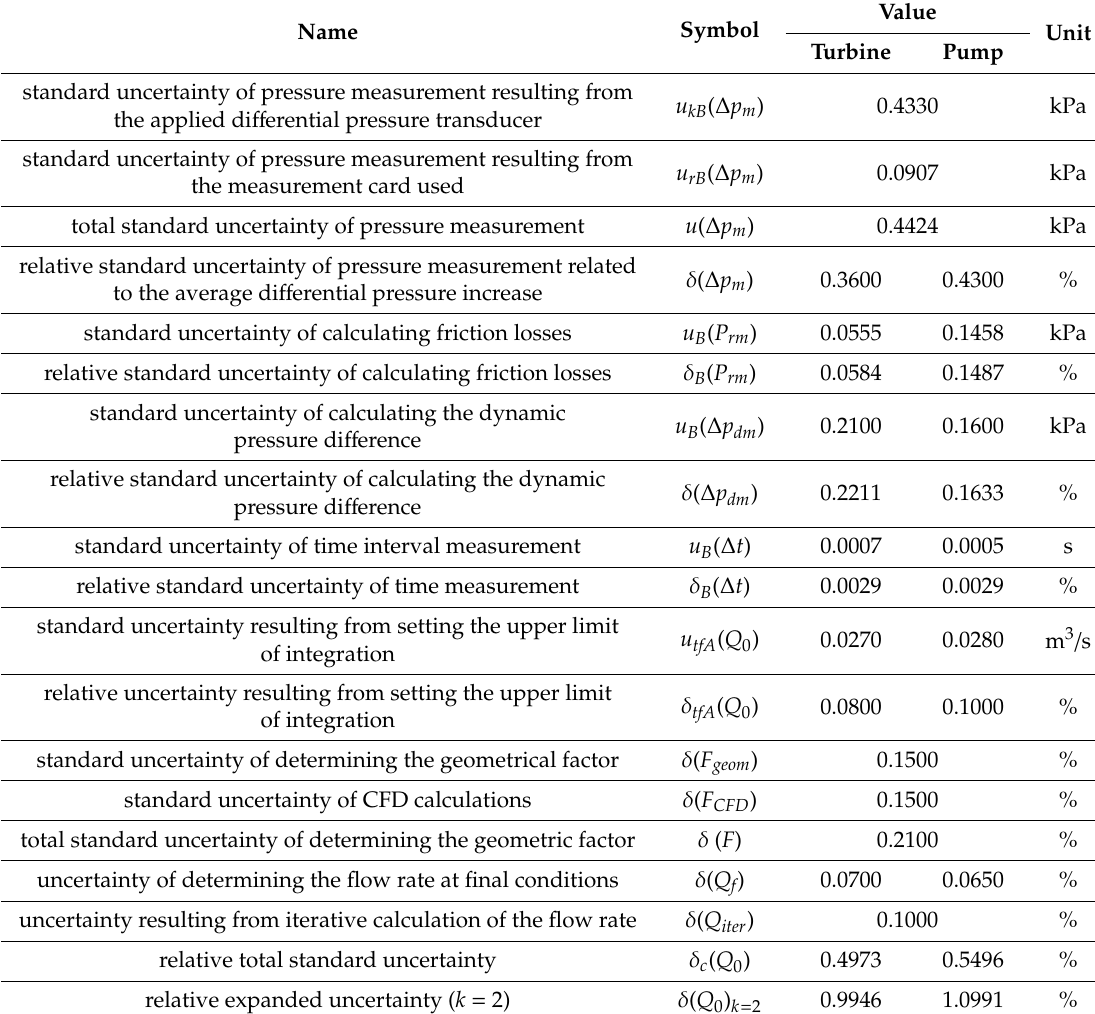
Table A2. Summary results of calculations of uncertainty of flow rate results measured using the pressure-time method. Name Symbol